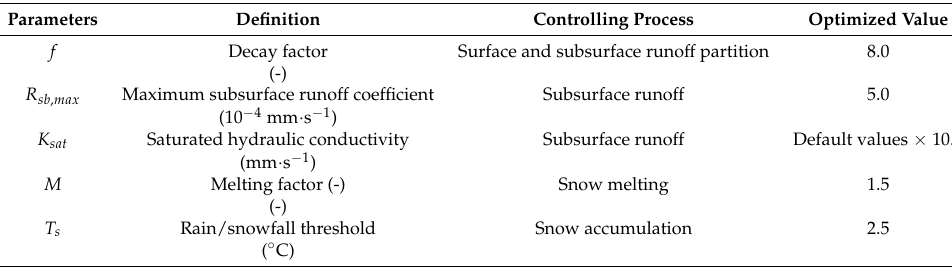
Table 3. The parameters calibrated in this study for the snow cover fraction and runoff, and the optimized parameters